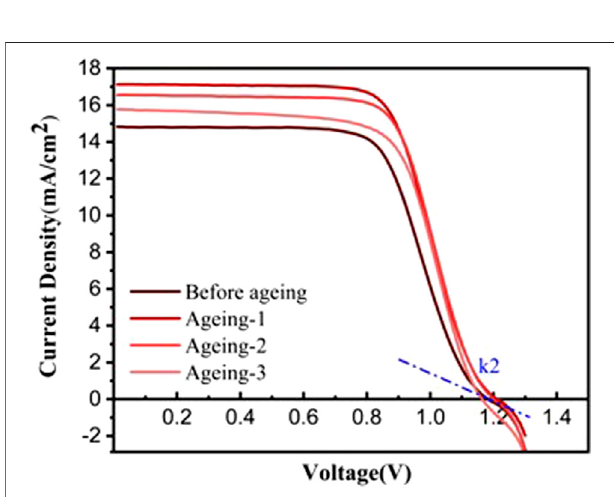
FIGURE 2 | J – V curves of NiO x -based PSCs in different ageing states.